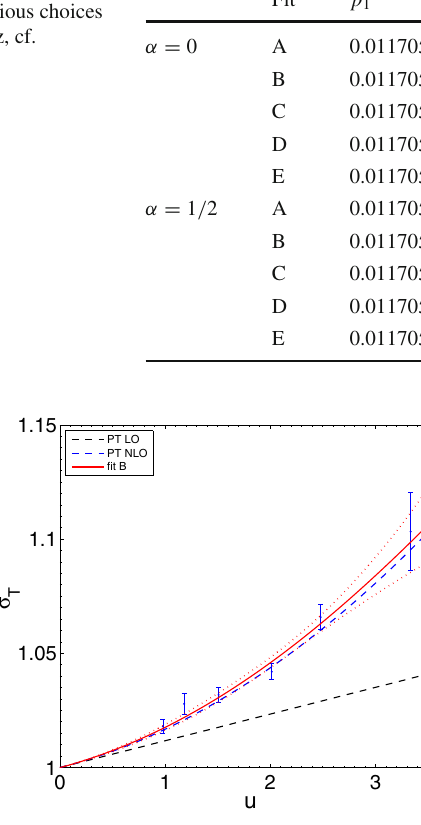
Fig. 9 SSF for N f = 2 in the scheme α = 0 (left) and α = 1 / 2 (right), compared with the LO and NLO perturbative